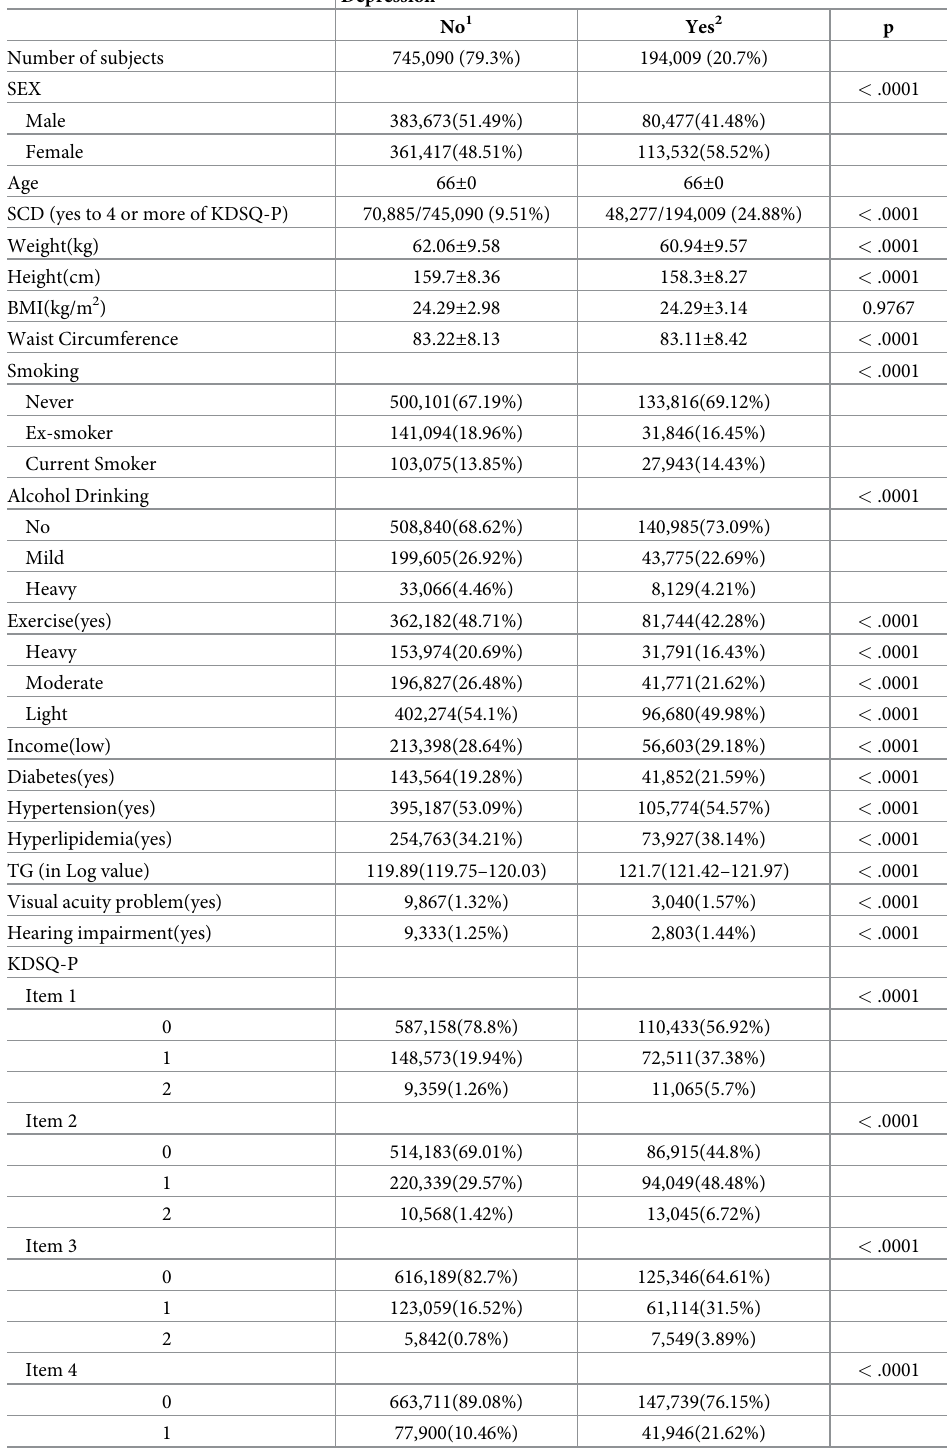
Table 1. Demographic and clinical data of patients who received mandatory public health screening at age of 66 years (total N =